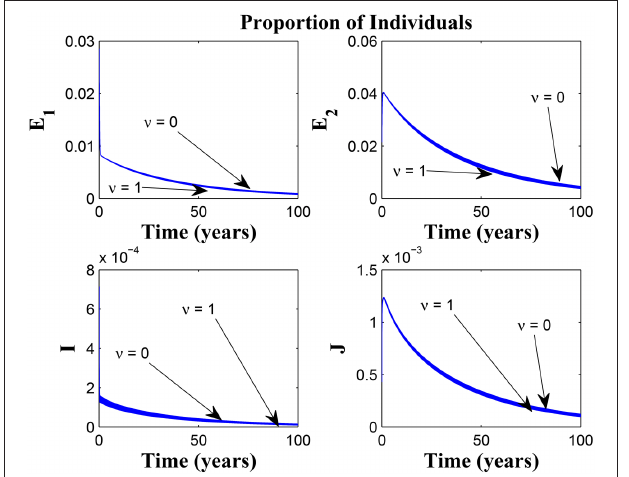
FIGURE 15 | Simulations of model (3) showing the number of infected individuals. Here, the reduced likelihood of infection due to awareness ( σ ) is varied from 0 to 1 with α 1 = α 2 = 20 , θ 1 = θ 2 = 20 and ψ = 30